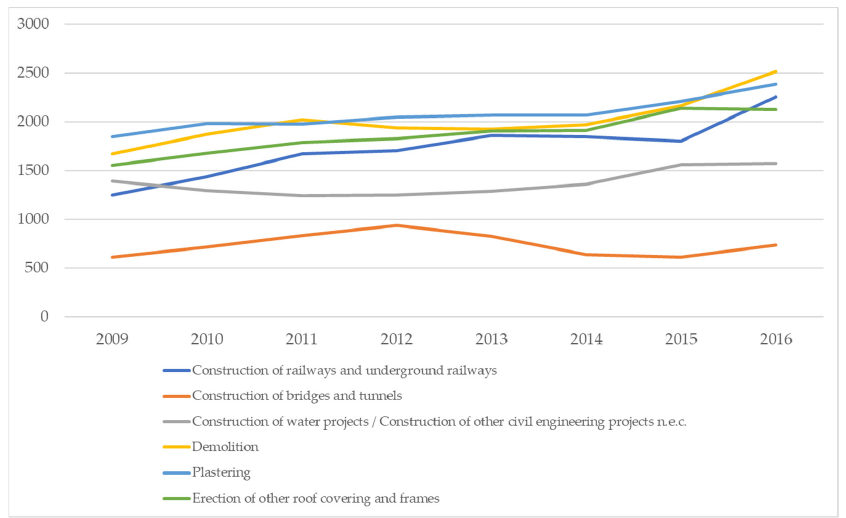
Figure 3. Number of employees in the six smallest subtrades, 2009–2016. Based on data from [27].